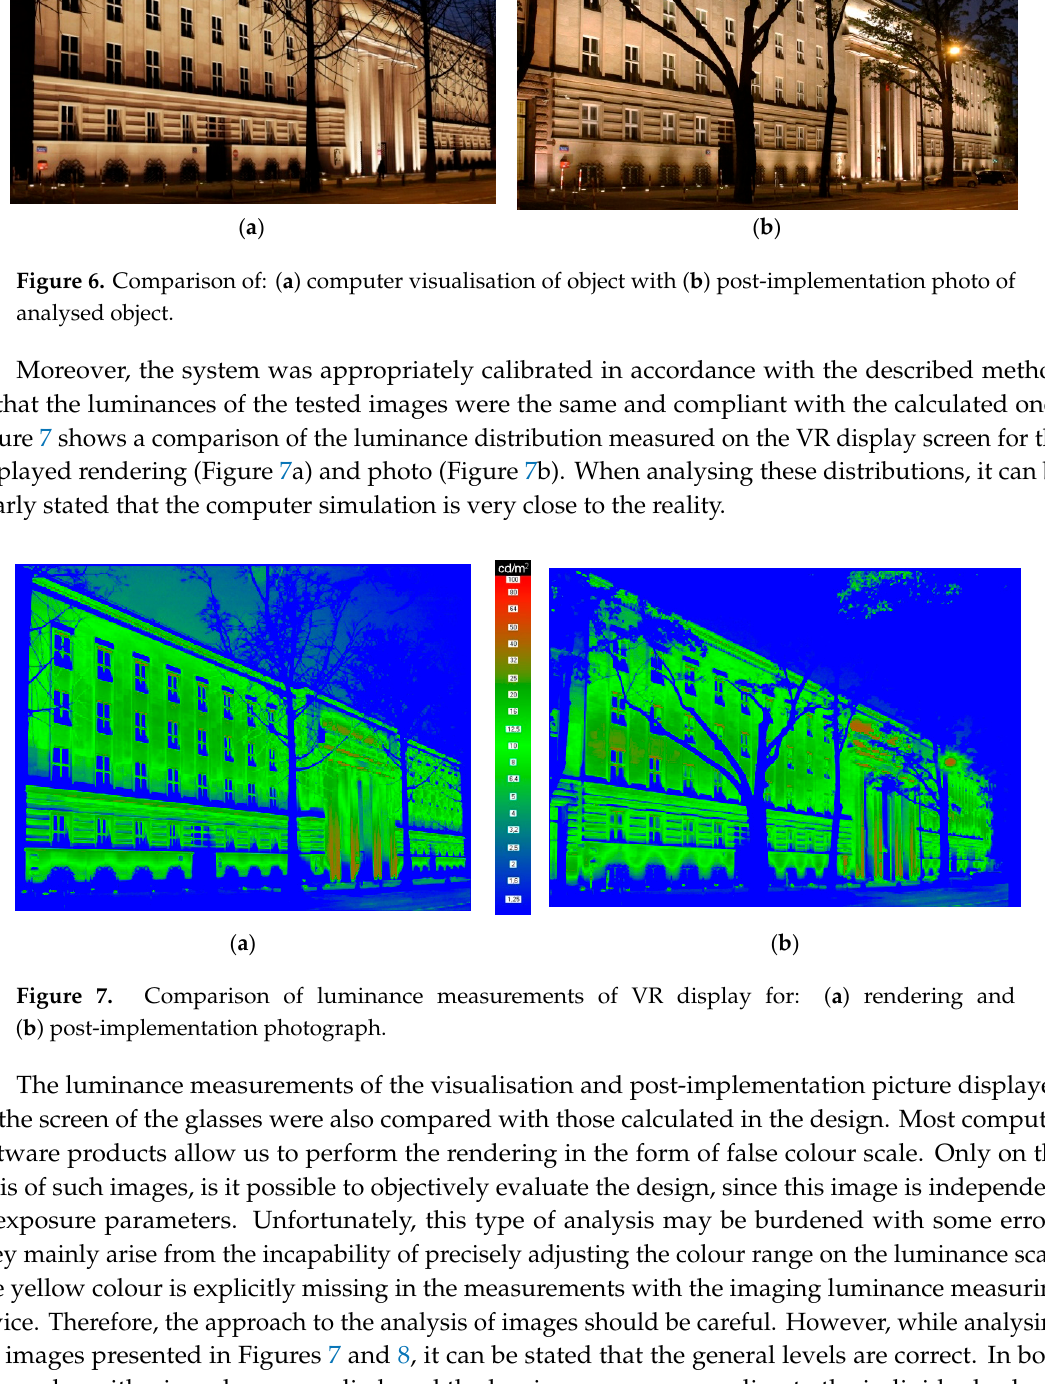
Figure 8. Computer-generated luminance distribution on virtual object.